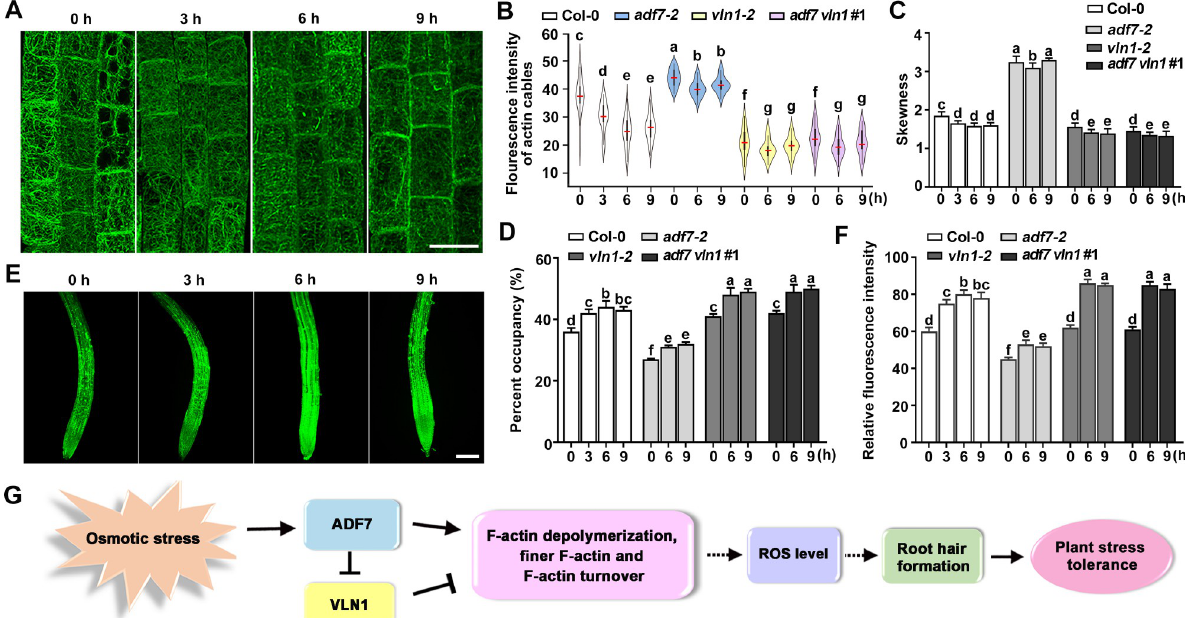
Fig 8. The pathway of ADF7-inhibited-VLN1 is involved in osmotic-induced F-actin depolymerization and ROS accumulation. (A) Confocal microscopy images of epidermal cells visualized by the expression of fABD2 :: GFP in root apices from Col-0 seedlings under mannitol treatments (200 mM) for 0, 3, 6, and 9 h. Scale bar, 20 μ m. (B) Violin plot showing the average and contribution of fluorescence intensity of actin cables in different genotypes seedlings under 200 mM mannitol treatments for different times. The red line represents the average fluorescence intensity in different genotypes. (C) Histogram depicting skewness of F-actin in (B) . (D) Histogram depicting the percentage of occupancy of F-actin in (B) . (E) ROS production in the roots of Col-0 seedlings under mannitol treatments (200 mM) for 0, 3, 6, and 9 h. Scale bar, 100 μ m. (F) Histogram depicting relative fluorescence intensities of the ROS levels in (E). (G) Working model of ADF7 and VLN1 in root hair formation and in response to osmotic stress in Arabidopsis . Arrows represent positive regulation, and bar ends mean inhibitory action. Osmotic stress induces ADF7 expression, which leading to the inclined F-actin depolymerization and the inhibited VLN1 expression that decreases F-actin bundle. The cooperation of ADF7 and VLN1 results in the increased F-actin depolymerization, finer F-actin and F-actin turnover, which associated with the increase ROS level and root hair formation in osmotic stress, then enhancing plant osmotic stress tolerance. At least 30 seedlings were examined for each genotype in different treatments. Significant difference ( P < 0.05) indicated by different letters among genotypes is determined for each condition by one-way ANOVA, followed by Tukey’s test in (B) , (C) , (D) , and (F)